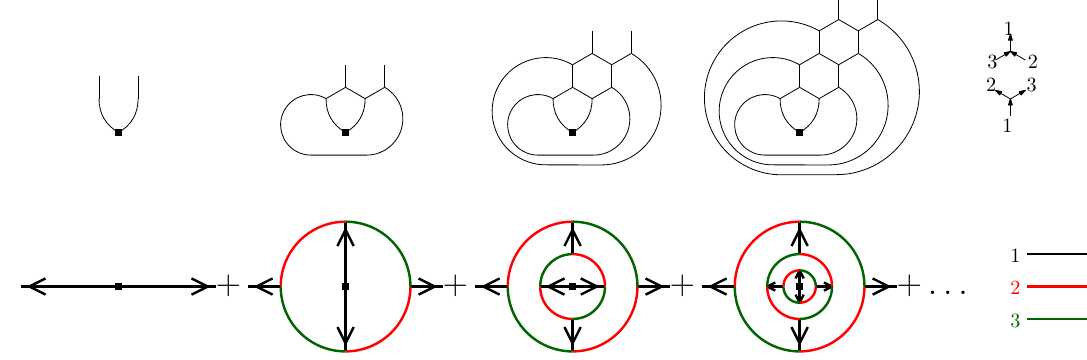
Figure 9 . Diagrammatic expansion of (cid:6) 11 . Each color represents a di(cid:11)erent type of (cid:12)eld, according to the legend on the right. The missing arrows can be inferred from the chirality of the vertices, they have been suppressed for the sake of clarity. The alternative representation of each diagram depicted above makes the (cid:12)shnet structure explicit by associating a direction on the plane to each